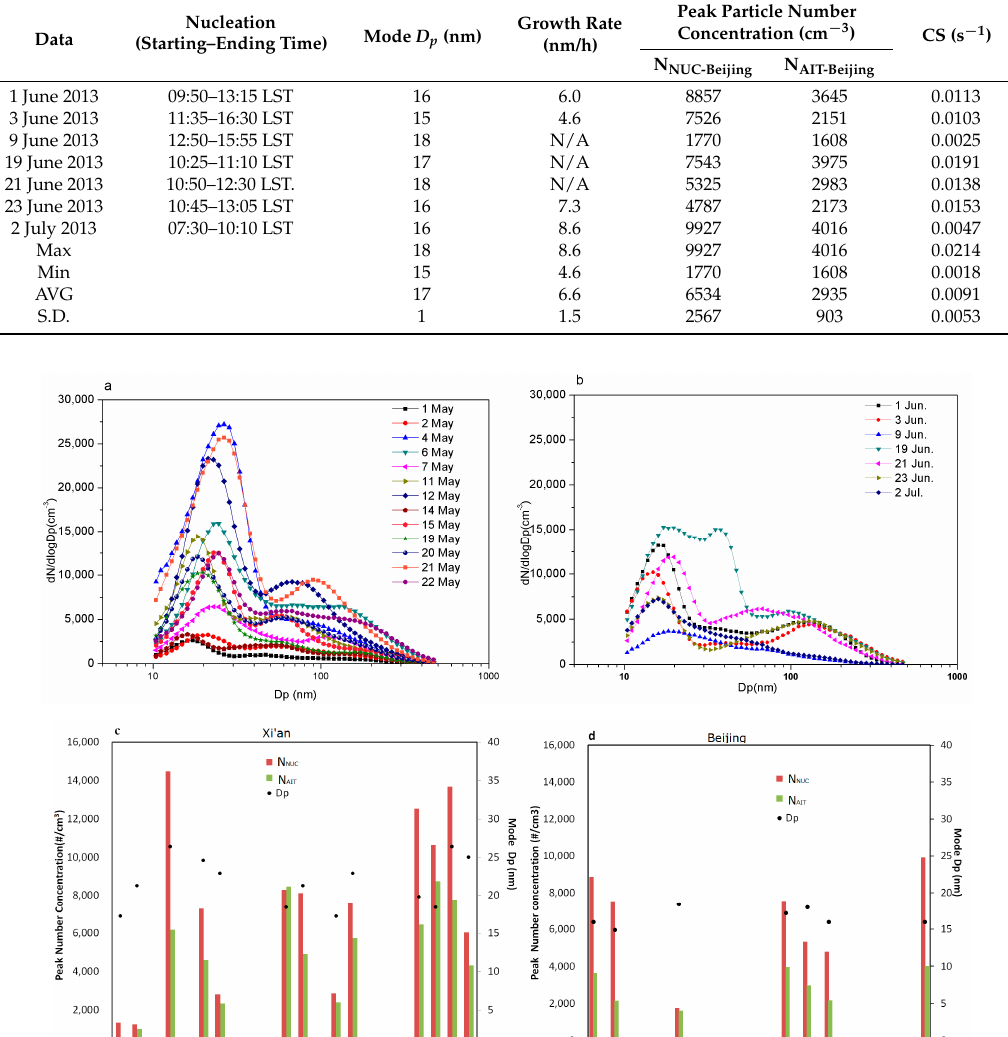
Table 3. Summary of NPF events at the suburban site of Beijing from 1 June to 2 July in 2013.